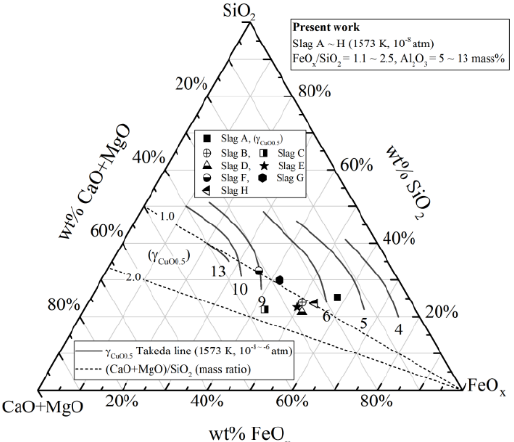
Figure 4. Activity coefficients obtained by the equilibrium experiment results compared with Takeda’s experimental data at 1573 K and P O2 = 10 − 8 –10 − 6 .